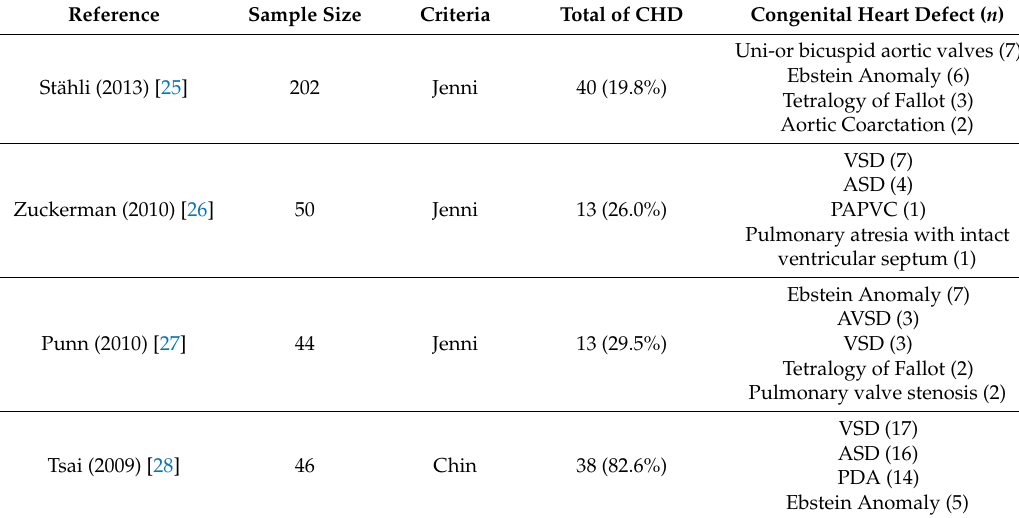
Table 1. Summary of the current studies available in literature about prevalence of congenial heart defects among cases of